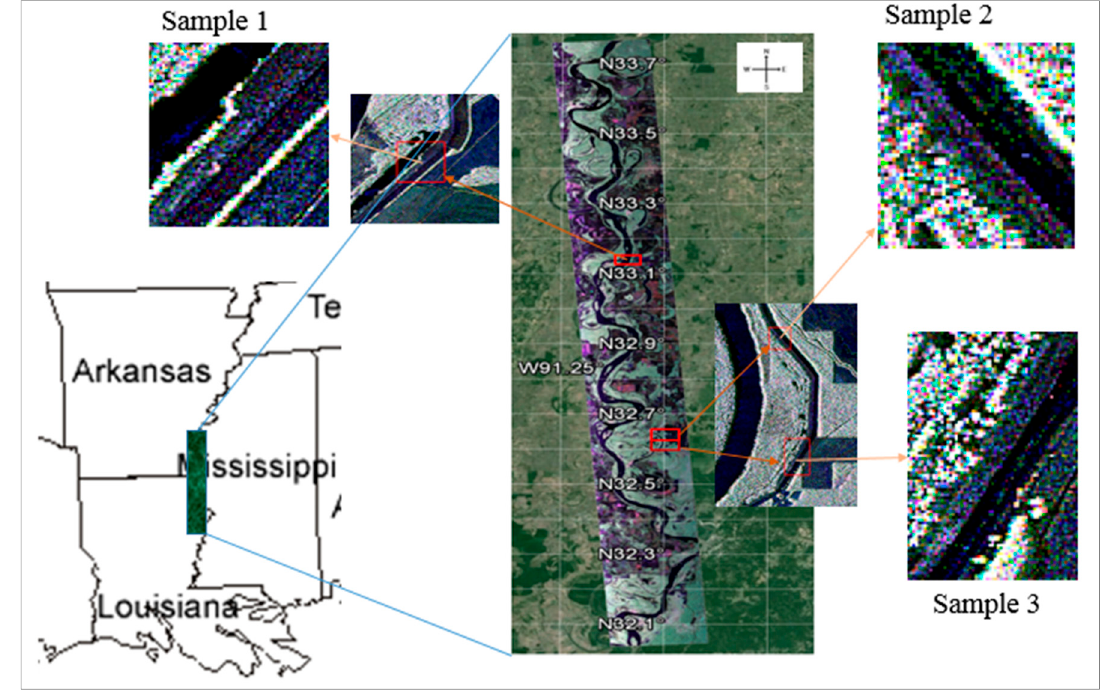
Figure 2. Study area with radar color composite 3 band (HH, VV and HV) image overlaid on base map.